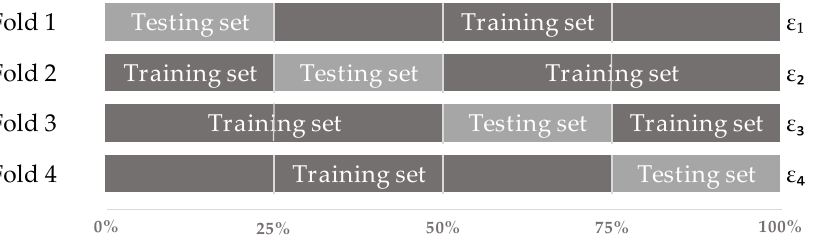
Figure 3. Four-fold Cross-Validation. The original dataset is partitioned into 4 equally sized subsets, which are repeatedly used as either test or training sets.